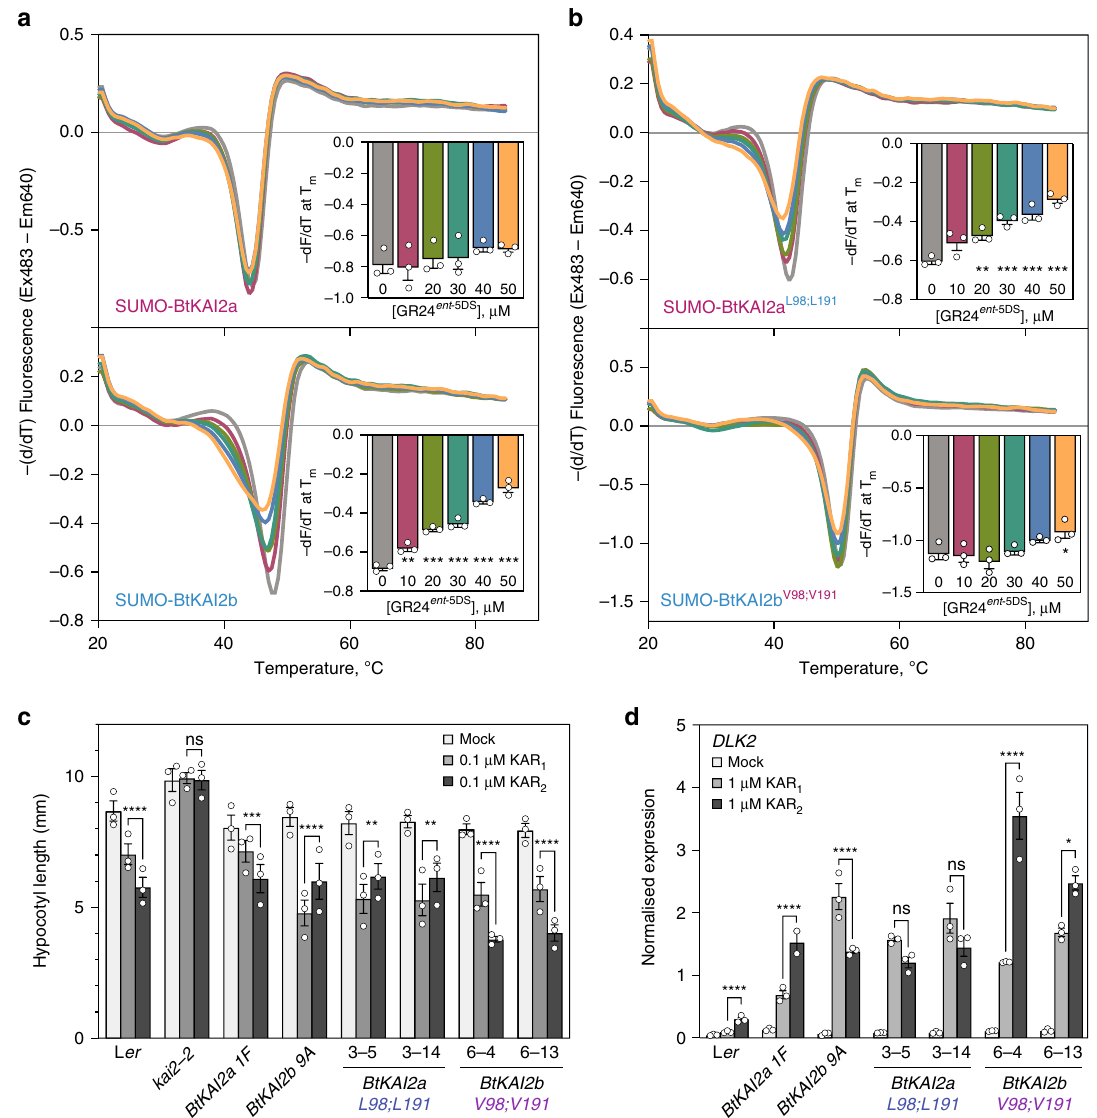
Fig. 4 Two residues account for ligand speci fi city between BtKAI2a and BtKAI2b. a DSF curves of SUMO-BtKAI2a and SUMO-BtKAI2b fusion proteins treated with 0 – 50 µ M GR24 ent -5DS , a KAI2-bioactive ligand. Each curve is the average of three sets of reactions, each comprising four technical replicates. Insets plot the minimum value of − (dF/dT) at the melting point of the protein as determined in the absence of ligand (means ± SE, n = 3). Signi fi cant differences from untreated control: * P < 0.05, ** P < 0.01, *** P < 0.001 (ANOVA). b DSF curves of SUMO-BtKAI2a L98;L191 and SUMO-BtKAI2b V98;V191 fusion proteins treated with 0 – 50 µ M GR24 ent -5DS . c Hypocotyl elongation responses of Arabidopsis expressing GFP-BtKAI2a L98;L191 and GFP-BtKAI2b V98; V191 fusion proteins and treated with KAR 1 or KAR 2 . Data are a summary of three experimental replicates performed on separate occasions, each comprising 25 – 40 seedlings per genotype/treatment combination. Data for each replicate are shown in Supplementary Fig. 11. Error bars are SE, n = 3 experimental replicates; each dot corresponds to the mean value derived from each replicate. Asterisks denote signi fi cant differences: * P < 0.05, ** P < 0.01, *** P < 0.001, **** P < 0.0001 (linear mixed model with experimental replicate as a random effect; speci fi c pairwise comparisons using Tukey ’ s HSD correction). d Levels of DLK2 transcripts in 8-day-old seedlings of the same transgenic lines as above treated with 1 µ M KAR 1 , 1 µ M KAR 2 , or 0.1% acetone (mock) and harvested 8 h later. Expression was normalised to CACS reference transcripts. Data are means ± SE of n = 3 pools of ~50 seedlings treated in parallel. Asterisks denote signi fi cant differences as above (two-way ANOVA; speci fi c pairwise comparisons using Tukey ’ s HSD correction). Source data are provided as a Source Data fi